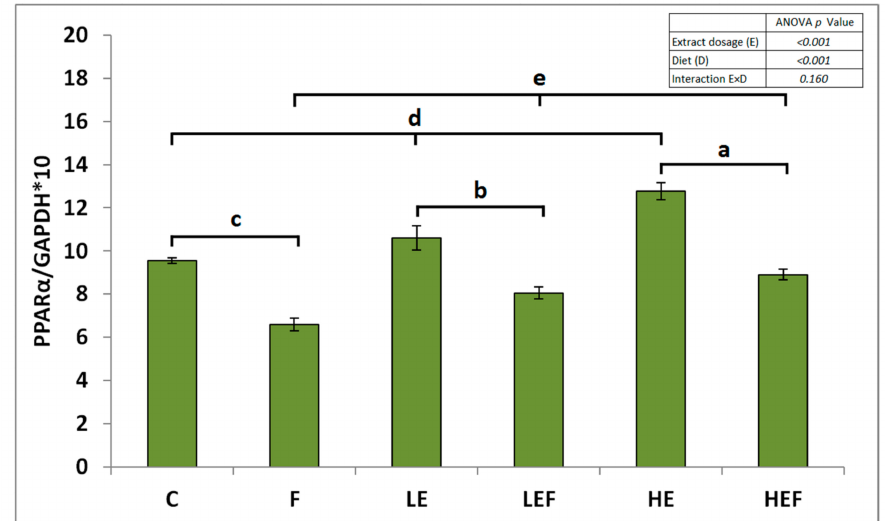
Figure 1. The mRNA expression of peroxisome proliferator-activated receptor α (PPAR α ) in the livers of rats fed experimental diets: the values are the means ± SEMs. To indicate a significant e ff ect (at p < 0.05) of the extract dosage, bars were marked with the letters a, b, or c, whereas to present an e ff ect of di ff erent types of diet, bars were marked with the letters d or e. C, control fed a diet with 53% corn starch; F, fed a diet with 14% pam oil added at the expense of corn starch; LE, fed a C-diet with a strawberry ET-rich extract at a low dosage of 0.24% of the diet; LEF, fed an F-diet with a strawberry ET-rich extract at a low dosage of 0.24% of the diet; HE, fed a C-diet with a strawberry ET-rich extract at a high dosage of 0.72% of the diet; and HEF, fed an F-diet with a strawberry ET-rich extract at a high dosage of 0.72% of the